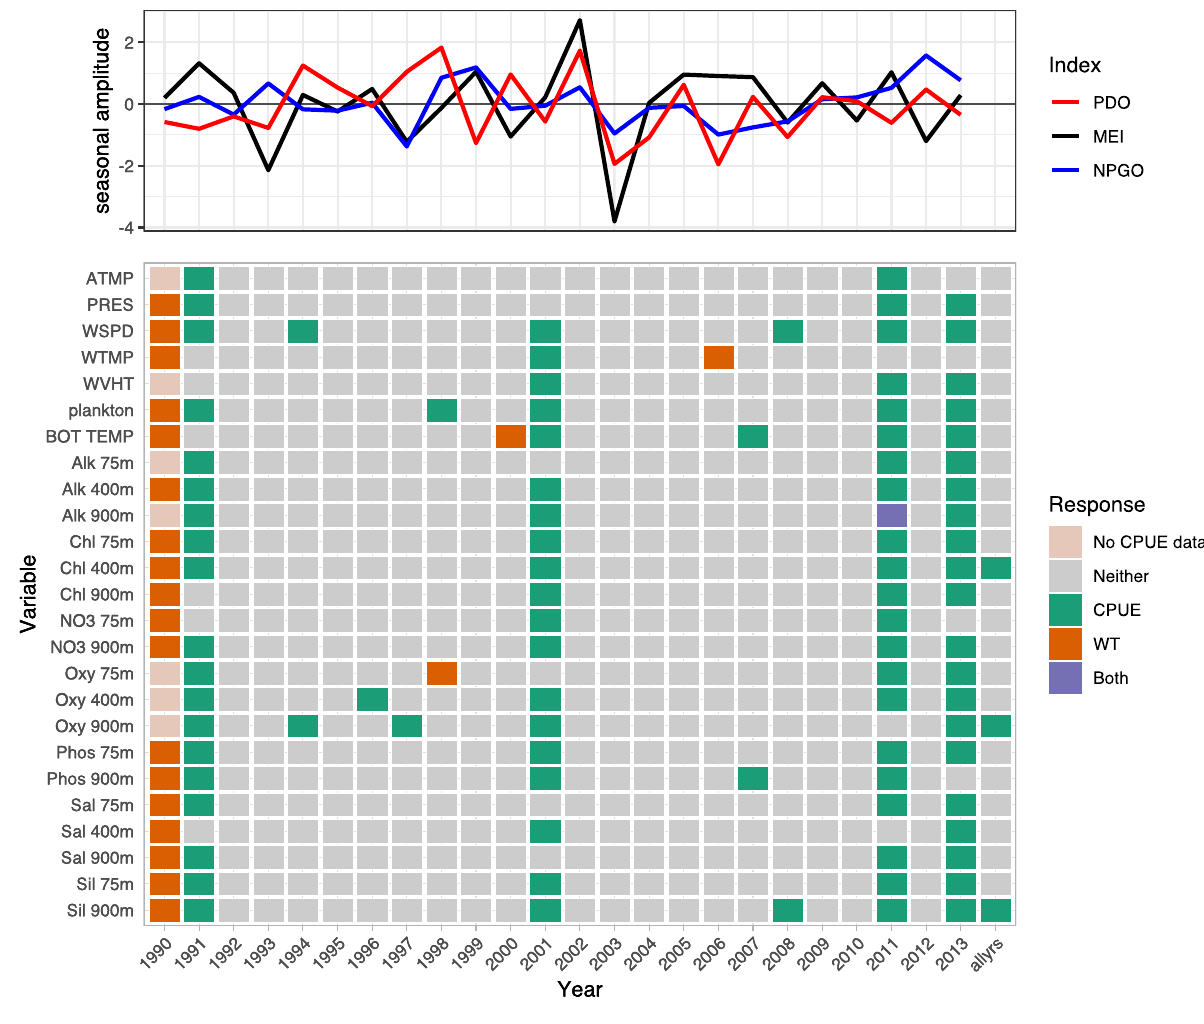
Figure 4. Variable selection analyzed for each available year and all years together for the SIVCMs with rougheye rockfish CPUE or WT as the response. Axes, colors, and line plot are as described in Fig.